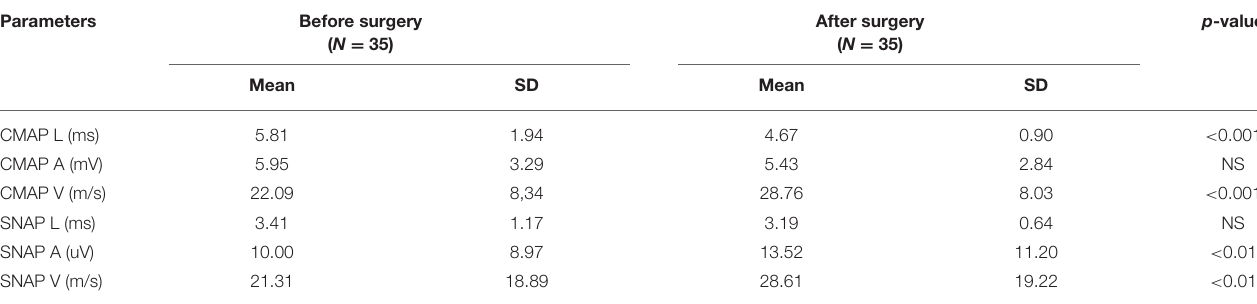
TABLE 1A | Mean values of standard motor and sensory conduction tests before and after surgery in CTS patients. Parameters Before surgery ( N = 35)